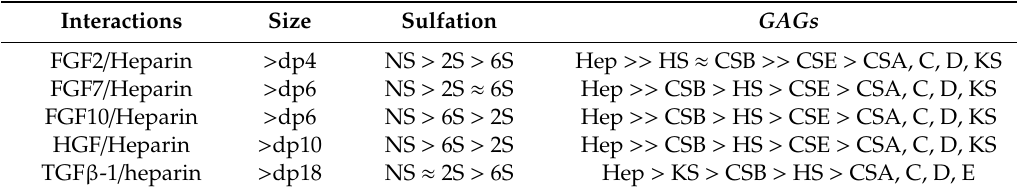
Table 2. Summary of structure preference of growth factor–GAG